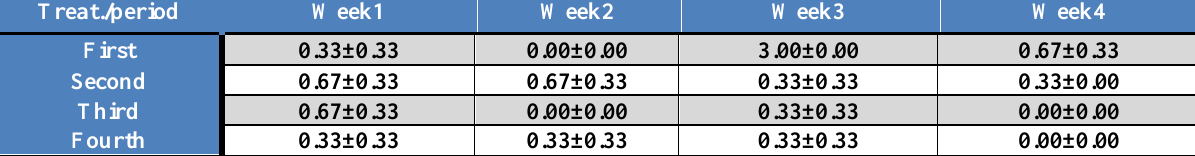
Table, 10: Effect of Vit. C and/or Vit.B on Glucose (mg/dl) of rabbits (Mean ± SE).